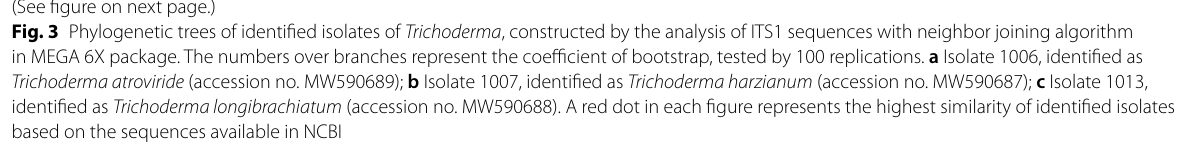
0.05. Error bars on graphs represent the Mean SE = ±